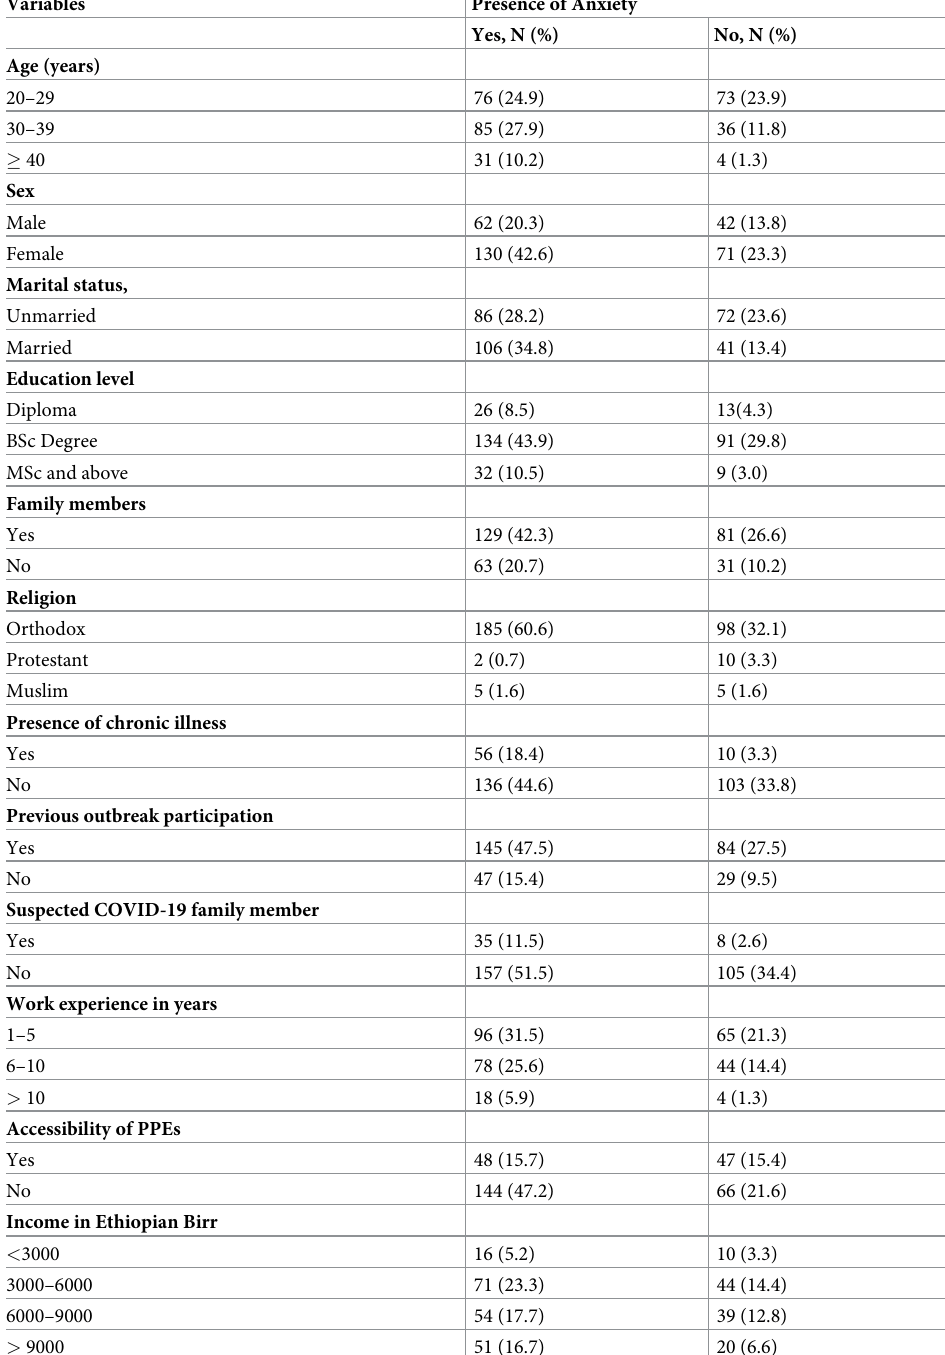
Table 2. Prevalence of anxiety towards COVID-19 among HCWs at a Hospital of Ethiopia.